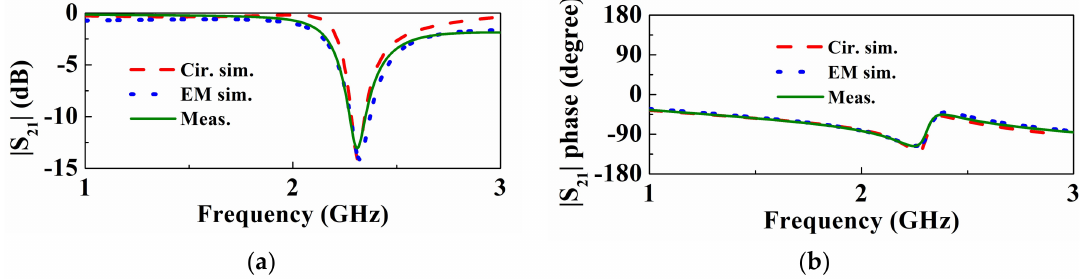
Figure 6. Transmission coefficient of the sensing structure with castor oil in the container. ( a ) Magnitude; ( b ) phase. Phase has been obtained after the reference plane